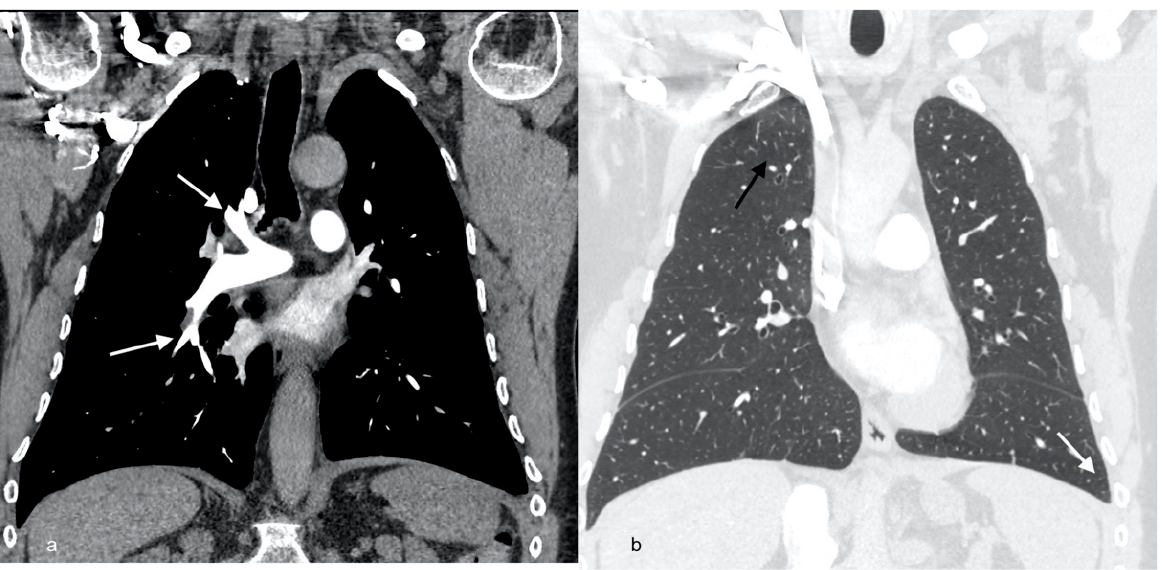
Figure 4. Computed tomography pulmonary angiography (CTPA) scan showing complete resolution of right pulmonary artery embolism (arrows) ( a ), high resolution computed tomography (HRCT) of the chest showing resolution of ground glass opacities in the right upper lobe) black arrow) and left-sided pleural effusion (white arrow) ( b ).